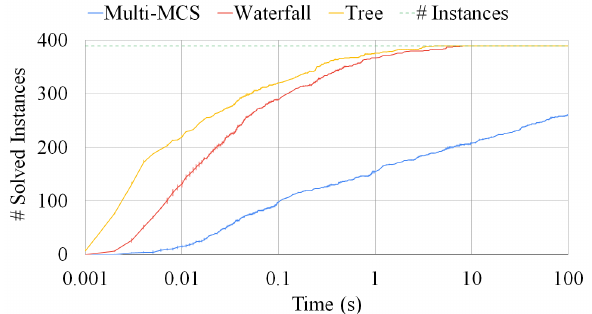
Figure 12. A comparison among the Multi-MCS, the waterfall, and the tree approaches. The plot reports the number of sets composed of three graphs solved as a function of the elapsed time. The fluctuations on the y-axis are due to the representation of the standard deviation over ten runs. The time limit is fixed at 100